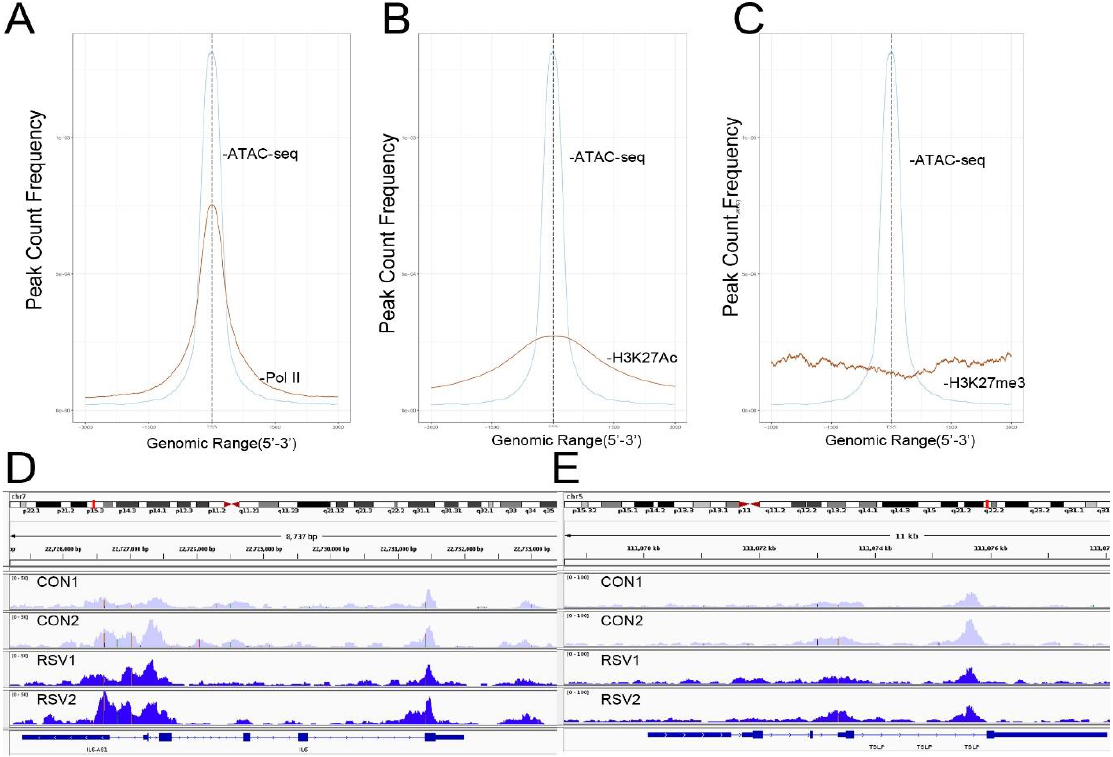
Figure 4. Open chromatin domains are enriched in active promoters. ( A ) Transcription factor overlap of ATAC-seq signals (blue tracing) with RNA Pol II (brown tracing). ( B ) Overlap with H3K27Ac. ( C ) Overlap with H3K27me3. ( D ) Integrated genomic viewer (IGV) of IL6 gene in control (purple) and RSV-infected state (blue). Note the substantial cleavage of IL6 gene body and proximal promoter in control cells, indicating chromatin accessibility. ( E ) IGV of TSLP. Transcription is from left to right. Transposase accessible regions cover the promoter, intron 2, and distal portion of intron 3.